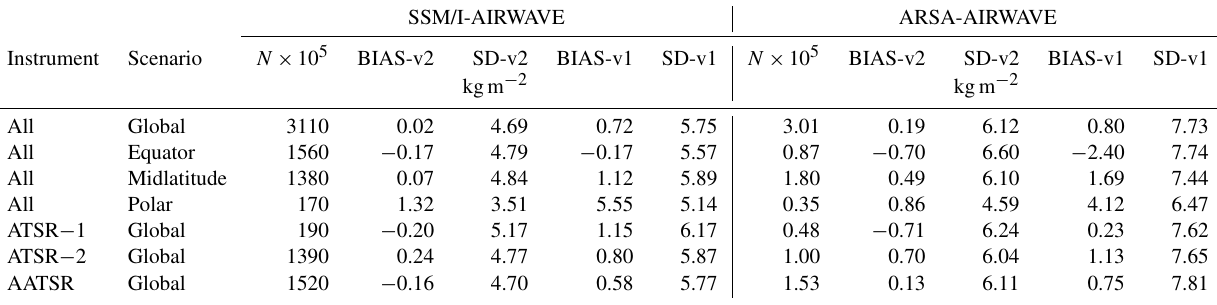
Table 2. AIRWAVE TCWVs compared with SSM/I and ARSA stations. Results are also given for AIRWAVEv1. Absolute differences along with the standard deviations are reported for the global (all latitudes), equatorial (25 ◦ S–25 ◦ N), midlatitude (25–60 ◦ S and 25–60 ◦ N) and polar (>60 ◦ N or >60 ◦ S) scenarios. Average values for ATSR-1, ATSR-2 and AATSR are also